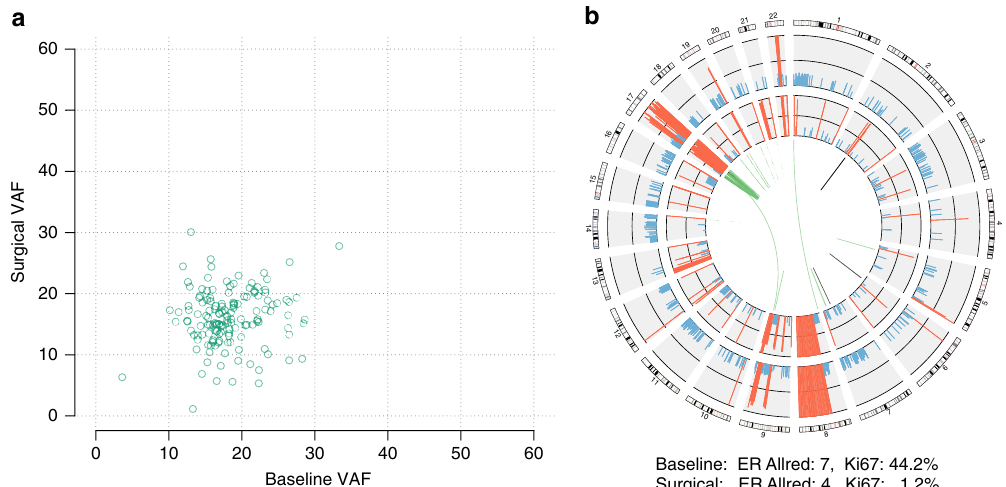
Figure 2 | Simple and stable clonal structure in BRC14. ( a ) Clonality plot comparing the variant allele fraction of SNVs in the baseline and surgical samples. ( b ) Gene fusions and copy number alterations. Outer ring: CN alterations in the baseline sample (amplifications in red, deletions in blue). Inner ring: CN alterations in the surgical sample. Centre: gene fusion events that were specific to the baseline (green) or surgical sample